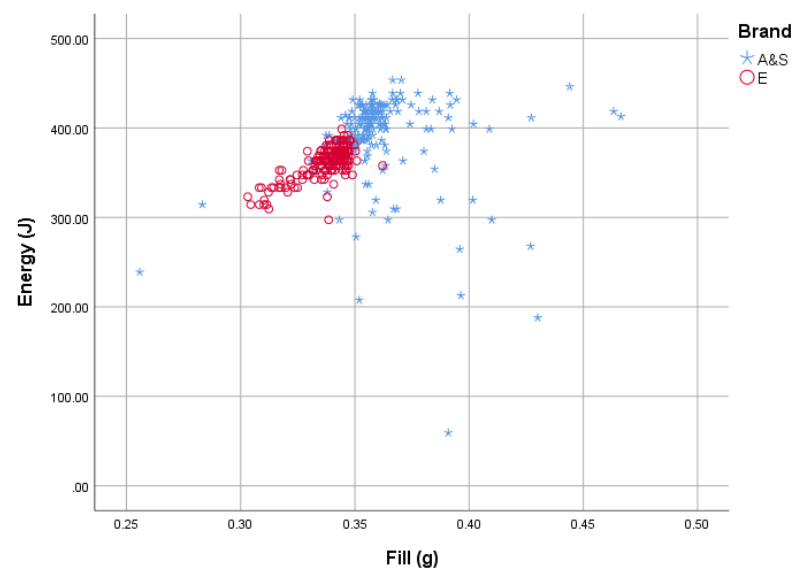
Figure 14. Scattergraph of calculated kinetic energy (J) against propellant fill weight (g).